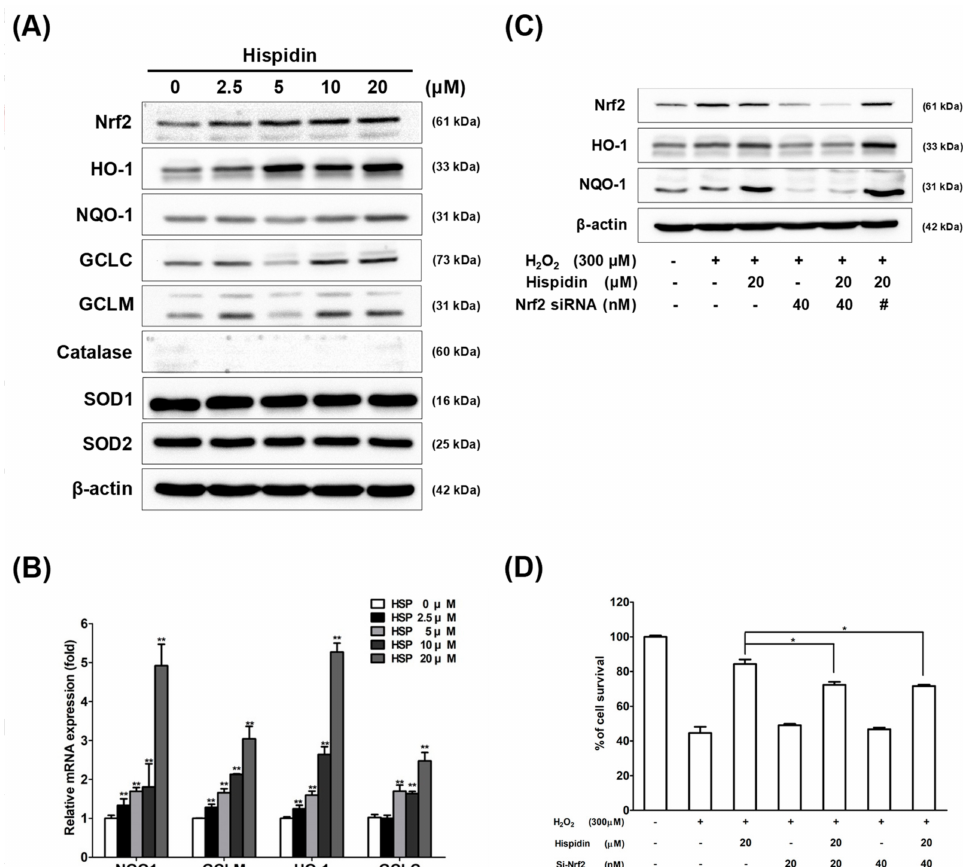
Figure 3. Activation of nuclear factor erythroid 2-related factor 2 (Nrf2) signaling is corelated with the protective e ff ect of hispidin against H 2 O 2 -induced cell death on ARPE-19 cells. ( A ) Cells were treated with various concentrations (2.5–20 µ M) of hispidin for 24 h, and the expression levels of Nrf2, heme oxygenase-1 (HO-1), NAD(P)H:Quinine oxidoreductase-1 (NQO-1), glutamate-cysteine ligase catalytic subunit (GCLC), glutamate-cysteine ligase modifier subunit (GCLM), catalase, superoxide dismutase 1 (SOD1), and superoxide dismutase 2 (SOD2) were analyzed by Western blot or real-time PCR ( B ). ( C ) Cells were transfected with 40 µ M Nrf2 siRNA or scramble siRNA (#) for 48 h, and then pre-treated with hispidin for 24 h, followed by 24 h H 2 O 2 treatment. Protein levels of Nrf2, HO-1, and NQO-1 were analyzed by Western blot, and cell viability was assessed by MTT assay ( D ). * p < 0.05 versus hispidin + H 2 O 2